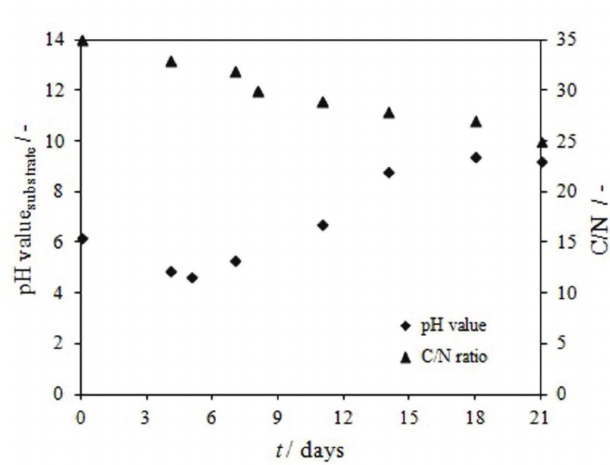
Fig. 1 – Change in pH value of substrate and C/N ratio during 21 days of